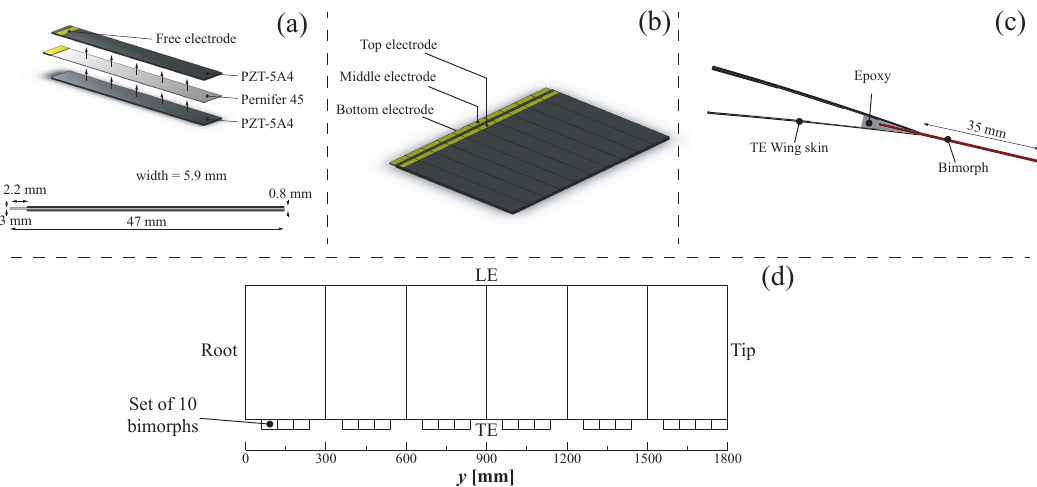
Figure 3. ( a ) Single piezoelectric bimorph. ( b ) Set of 10 bimorphs connected in parallel. ( c ) Cross- section of the trailing edge. ( d ) Distribution of the 19 sets of 10 bimorphs in the SmartX